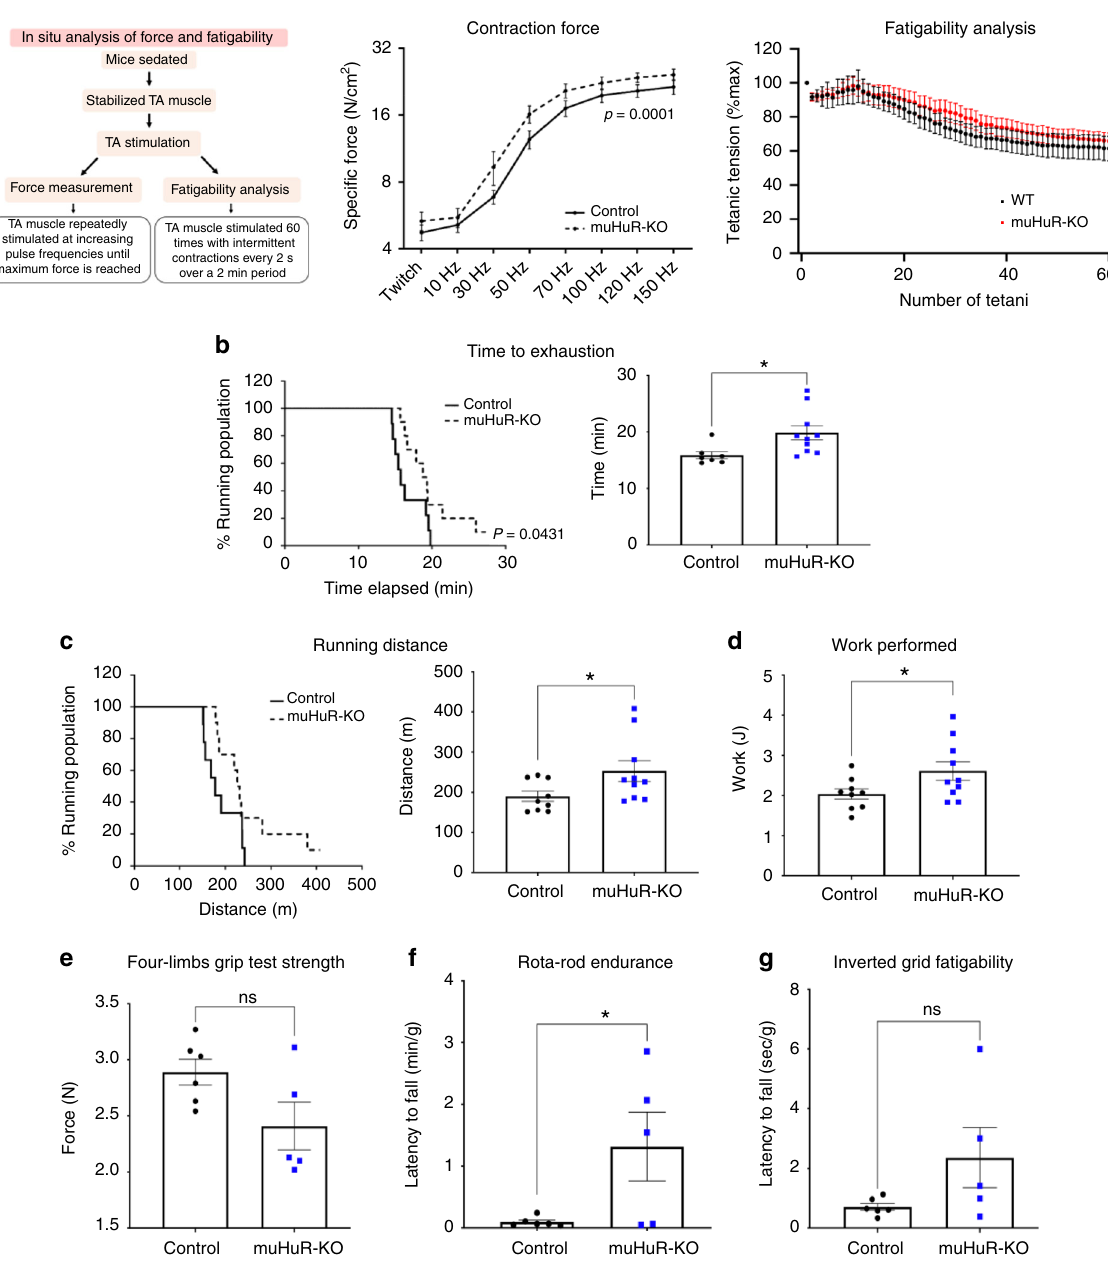
Fig. 2 HuR muscle-speci fi c KO mice have enhanced exercise endurance . a Left panel: schematic describing the method used to determine, in situ, force measurement, and fatigability of control and muHuR-KO mice. Middle panel: contractile function of the TA muscle was assessed in situ at various stimulation frequencies (Control: n = 8, muHuR-KO: n = 6). Right panel: fatigability of TA muscle was assessed in situ over 60 stimulation sessions with a resting period of 2 min between stimuli. Fatigability was normalized to TA muscle weight shown in (Supplementary Fig. 1a) (Control: n = 8, muHuR-KO: n = 6). b – g Physical performance was evaluated in age-matched control and muHuR-KO mice by performing a treadmill exhaustion test. Three parameters were measured with this test: b Time to exhaustion (left panel; survival plot showing the percentage of mice running at indicated time points. Right panel; mean duration of the run). c Running distance (left panel; survival plot showing the percentage of mice running at indicated distances. Right panel; mean distance ran) and d Work performed during test. [ b Control: n = 7, muHuR-KO: n = 10, c control: n = 9, muHuR-KO: n = 10, d control: n = 9, muHuR-KO: n = 10]. e Grip strength was evaluated on control and muHuR-KO mice using a digital force gauge. Mice were allowed to grip using their four limbs (forelimb and hindlimbs) and peak force was measured in triplicate during two sessions (Control: n = 6, muHuR-KO: n = 5). f Endurance performance was assessed using a Rota-rod system. For each animal, the duration on the rod was measured twice with a resting period of 4 days in between. The latency to fall represents an average of the two sessions of evaluation (Control: n = 6, muHuR-KO: n = 5). g Fatigability was evaluated by performing an inverted-grid test, the latency to fall represents an average of two sessions of evaluation normalized to total body weight (Control: n = 6, muHuR-KO: n = 5). Statistical analysis for in situ data shown in a was performed using two-way ANOVA. The results are presented as mean ± S.E.M, * p < 0.05 unpaired t -test b – g Source Data are provided in the Source Data